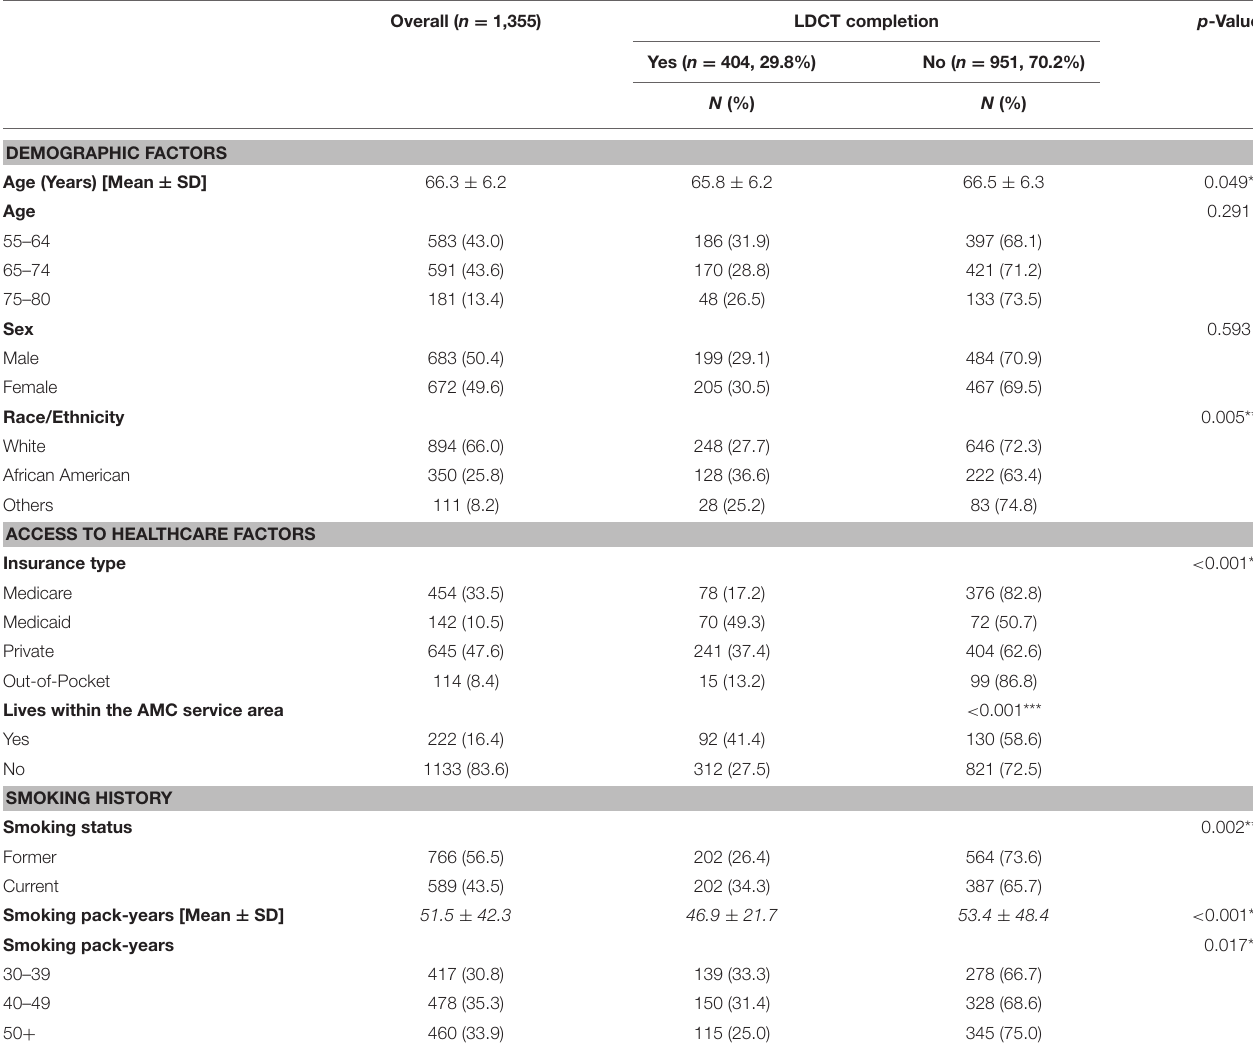
TABLE 1 | Characteristics of the study sample ( N =